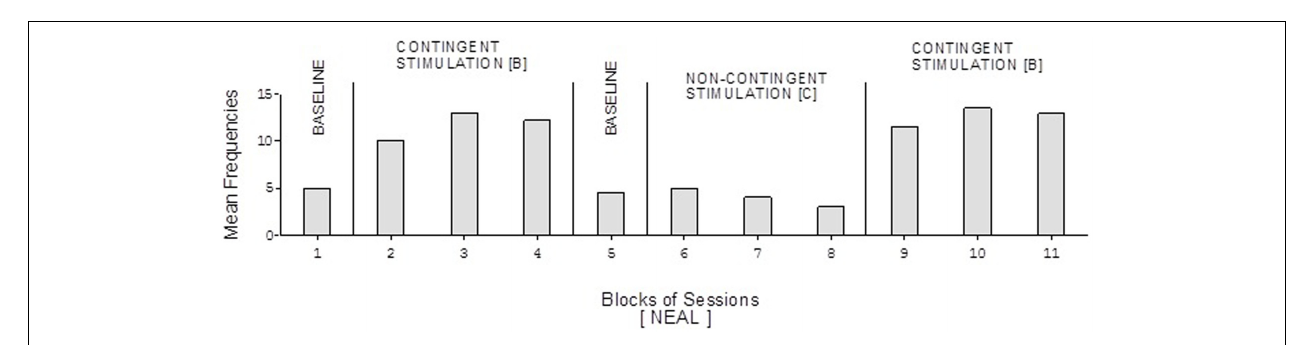
FIGURE 5 | Neal’s data plotted as in Figure 2.